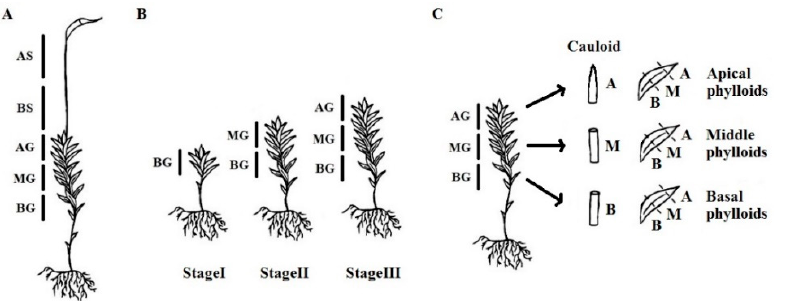
Figure 1. Schematic drawings of moss separation for sample preparation. ( A ) separation of gameto- phyte and sporophyte in Experiment 1, ( B ) separation of in vitro cultivated gametophytes in three ontogenetic stages, StageI, StageII and StageIII in Experiment 2, ( C ) separation of organs, cauloid and three spatially different types of phylloids in Experiment 3. BG, basal part of gametophyte; MG, middle part of gametophyte; AG, apical part of gametophyte; BS, basal part of sporophyte; AS, apical part of sporophyte; B, basal part of an organ; M, middle part of an organ; A, apical part of an